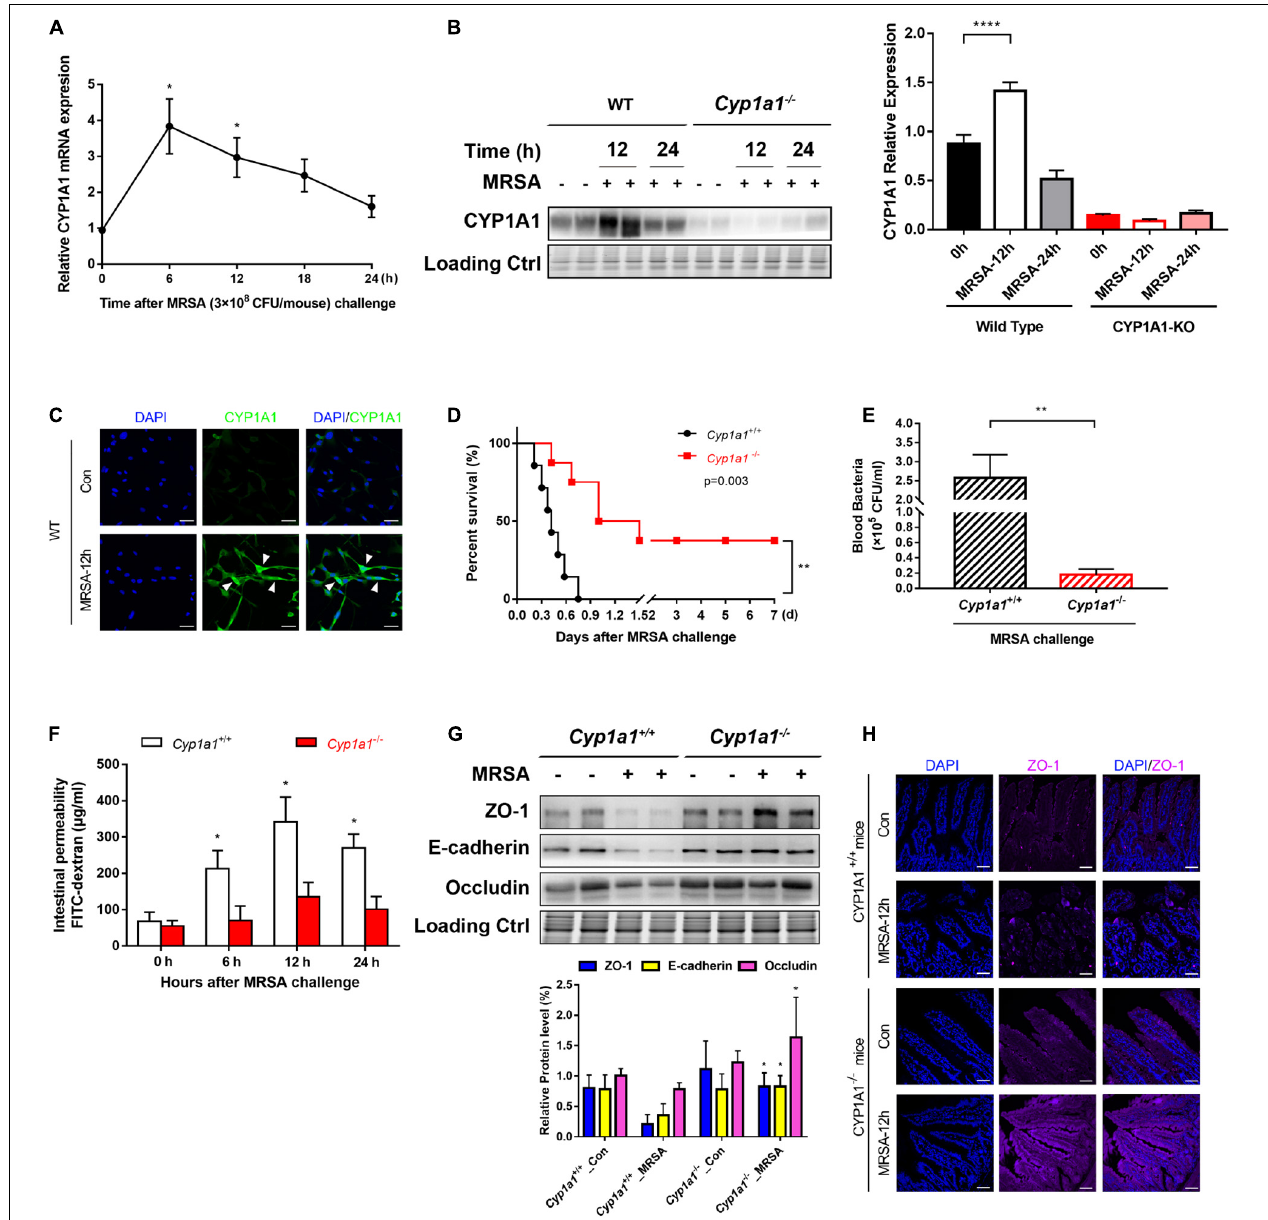
FIGURE 1 | Cyp1a1 − / − mice are protected from methicillin-resistant Staphylococcus aureus (MRSA)-induced sepsis and intestinal barrier disruption. (A) mRNA levels of CYP1A1 at 12 h post-MRSA infection (p-Mi) in the ileal epithelium of wild type (WT) mice ( n = 3–4). (B) Immunoblot and densitometry plots of MRSA-induced CYP1A1 levels in the ileal epithelium from CYP1A1-knockout ( Cyp1a1 − / − ) mice ( n = 5–6) or WT mice ( n = 5–6). (C) Representative immunostaining of IECs CYP1A1 (green) from WT mouse ileum, DAPI (blue) before (Control; Con) or at 12 h p-Mi (MRSA-12 h). (D) Survival of Cyp1a1 + / + ( n = 10) and Cyp1a1 − / − ( n = 9) mice subjected to MRSA from three independent experiments. (E) Cyp1a1 + / + ( n = 3) and Cyp1a1 − / − ( n = 3) bacterial colony forming units (CFUs) in the peripheral blood were calculated at 12 h p-Mi from two independent experiments. (F) Intestinal permeability was measured at 12 h p-Mi from three independent experiments ( n = 8 mice/group). (G) Immunoblot and densitometry plots of cell junction proteins in the ileal epithelium from two mice before or 12 h p-Mi ( Cyp1a1 + / + mice, n = 5–6; Cyp1a1 − / − mice, n = 5–6). Differences were analyzed using one-way ANOVA. (H) Immunofluorescence staining of ileum sections of Cyp1a1 + / + mice and Cyp1a1 − / − mice for ZO-1 (purple) and DAPI (blue). Scale bar: 40 µ m. Error bars, ± SEM. * P < 0.05, ** P < 0.01, **** P < 0.0001.